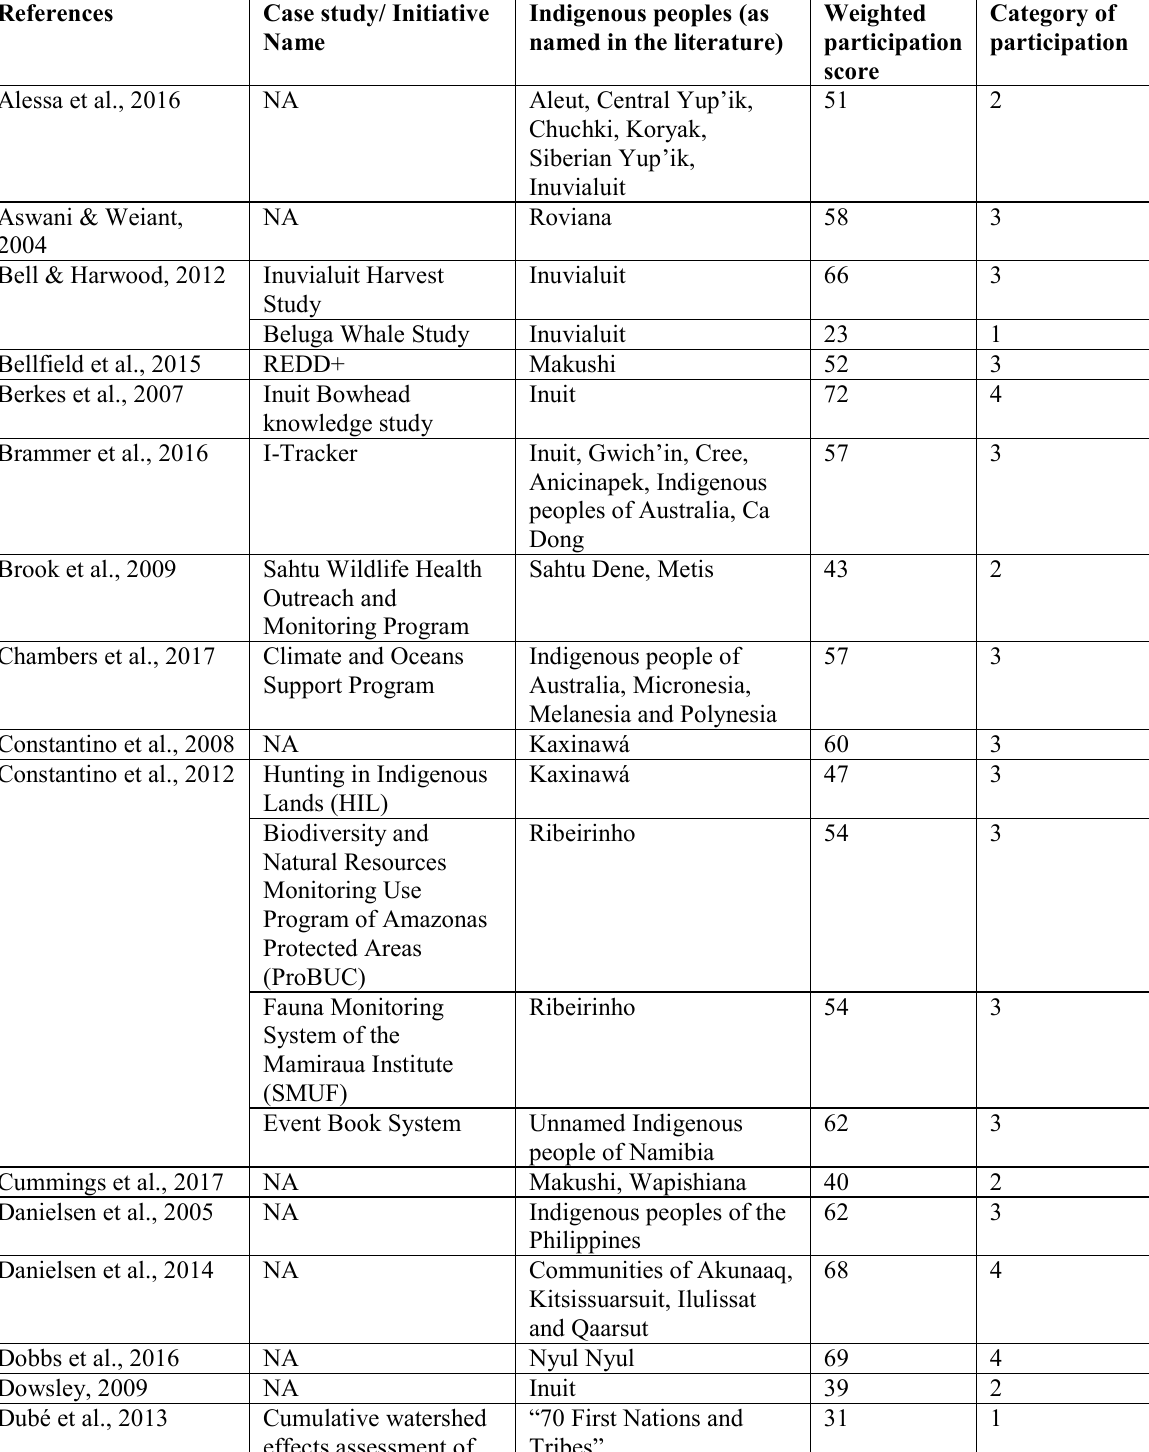
Table A1.1. Reviewed literature, participating Indigenous groups, and categorization of